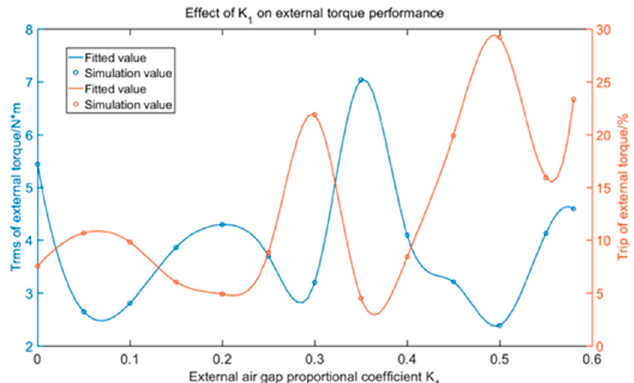
Energies 2020 , 13 , x FOR PEER REVIEW Figure 6. Relationship between K 1 and the performance of the external torque. Figure 6. Relationship between K 1 and the performance of the external torque.